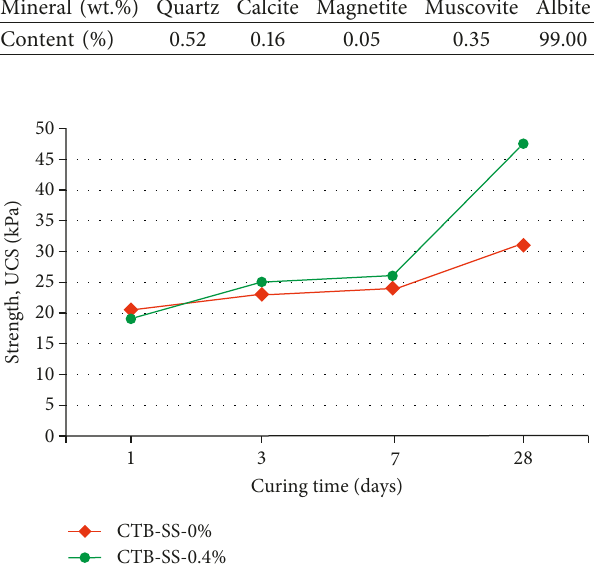
Figure 2: Strength evolution of CTB for different SS contents at early ages.